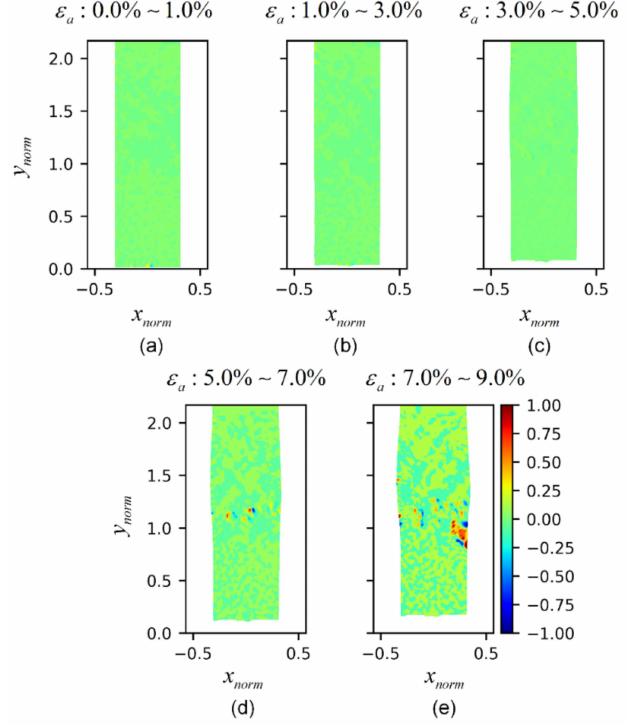
Figure 27. Evolution of curl along ˆ ρ axis ( curl U ) of test 120704c: ( a ) axial strain 0.0%–1.0%; ( b ) axial ρ strain 1.0%–3.0%; ( c ) axial strain 3.0%–5.0%; ( d ) axial strain 5.0%–7.0%; ( e ) axial strain 7.0%–9.0%.